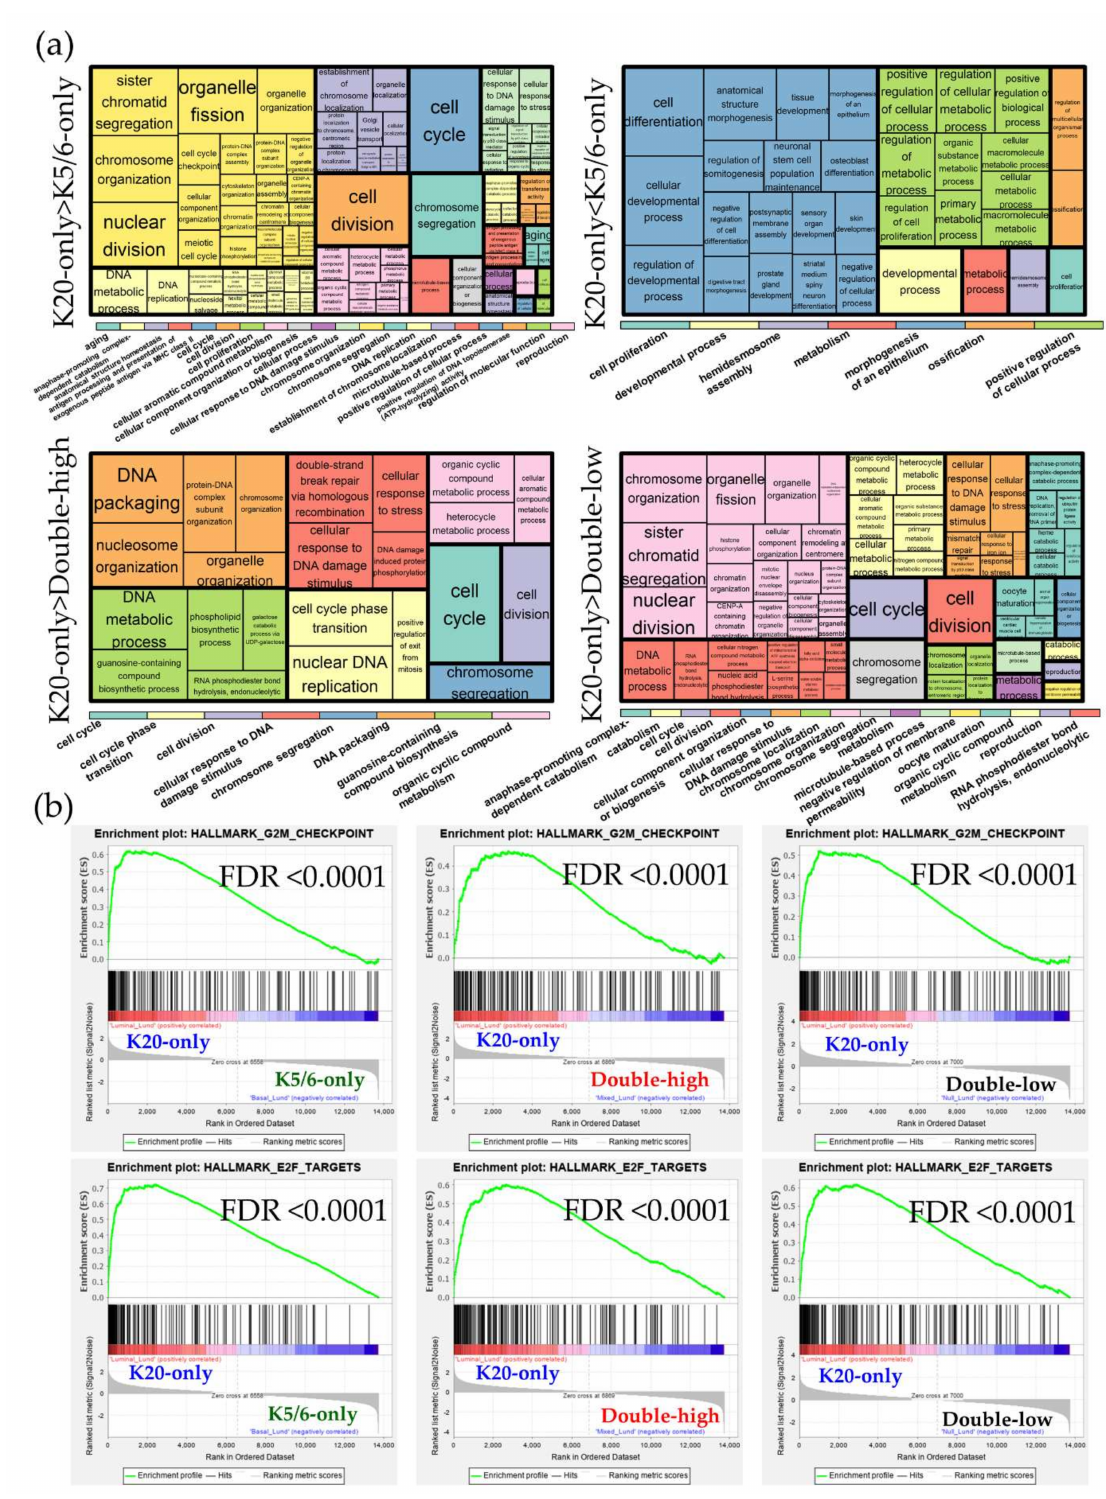
Figure 3. Functional enrichment analyses of the di ff erentially expressed genes (DEGs) identified in the Lund groups. ( a ) Gene ontology-biologic processes enriched in the upregulated genes from each comparison. The overarching gene ontology categories are demonstrated with color bars ( b ) Hallmark gene sets related to cell proliferation from the Gene Set Enrichment Analysis